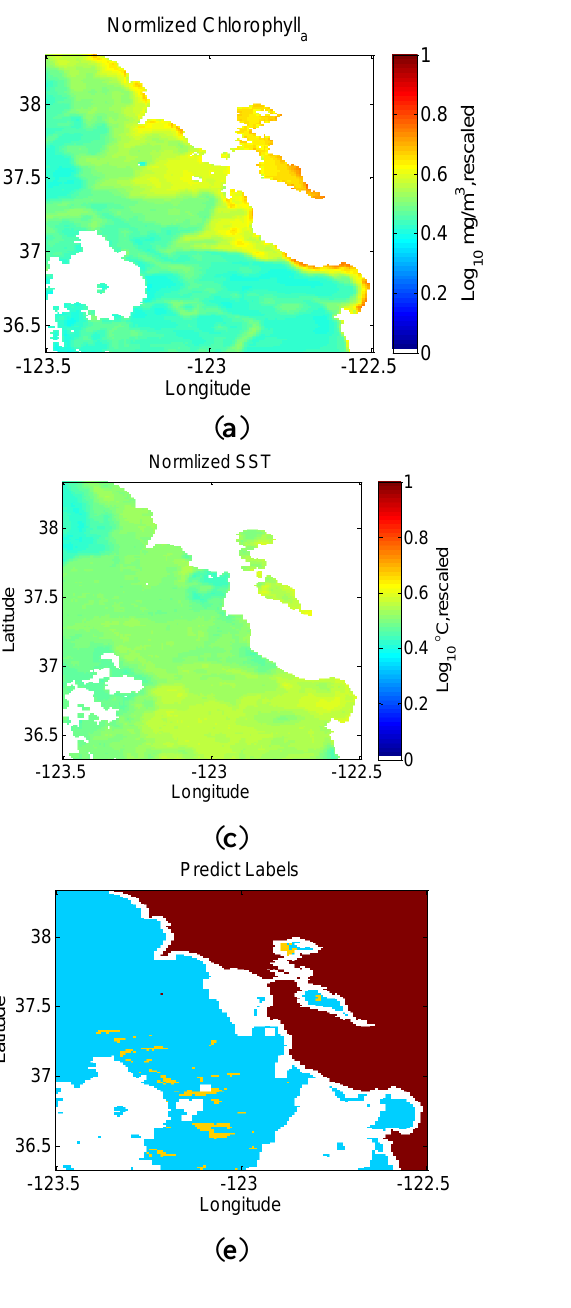
Figure 9. Test results for 31 January 2011. ( a – d ) represent MODIS-measured chlA, flh, sst and k490. ( e – f ) show labels predicted from the RF model (left) and MERIS MCI (right), respectively. Bloom pixels are shown in yellow, and non-bloom pixels in blue. White areas represent unknown pixels and land is red in the bottom row. Since the labels are generated only for the subset of known MERIS and MODIS imagery, the labels contain a smaller set of pixels than the MODIS images